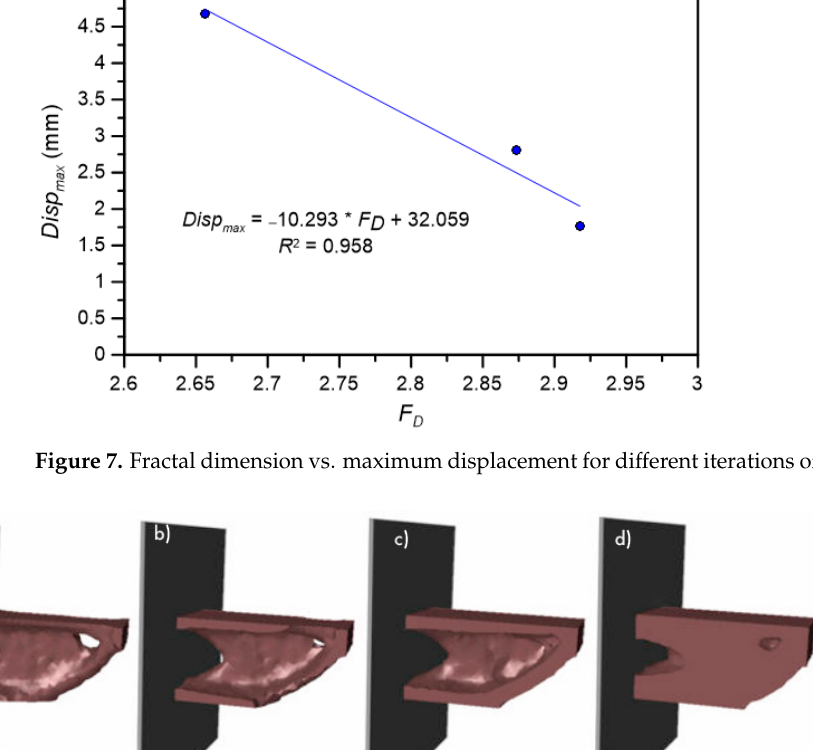
Figure 7. Fractal dimension vs. maximum displacement for different iterations of the Menger sponge.